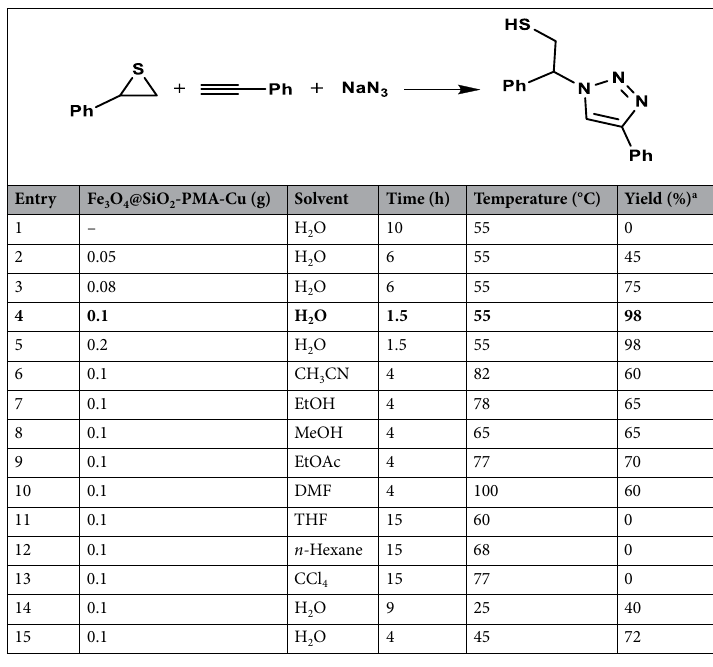
Table 1. Reaction of styrene episulfide with phenylacetylene and sodium azide catalysed by Fe 3 O 4 @SiO 2 - PMA-Cu under different conditions. All reactions were performed using styrene episulfide (1